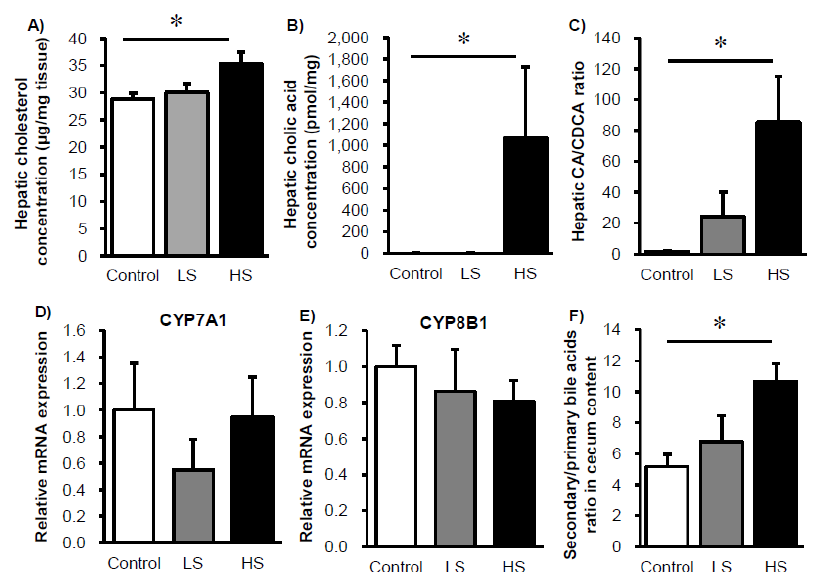
Figure 2. Cholesterol and bile acid metabolism are altered in mice fed sucralose. Changes in hepatic cholesterol ( A ), cholic acid ( B ) CA/CDCA ratio ( C ), mRNA expression levels of CYP7a1 ( D ), CYP8b1 ( E ), and luminal primary and secondary bile acid ratio ( F ) in mice fed sucralose for 8 weeks. Data represent mean ± S.E. ( n = 8). * Concentration-dependent effects were observed by regression analysis, p < 0.05. LS: low sucralose (1.5 mg/kg BW/day), HS: high sucralose (15 mg/kg BW/day).